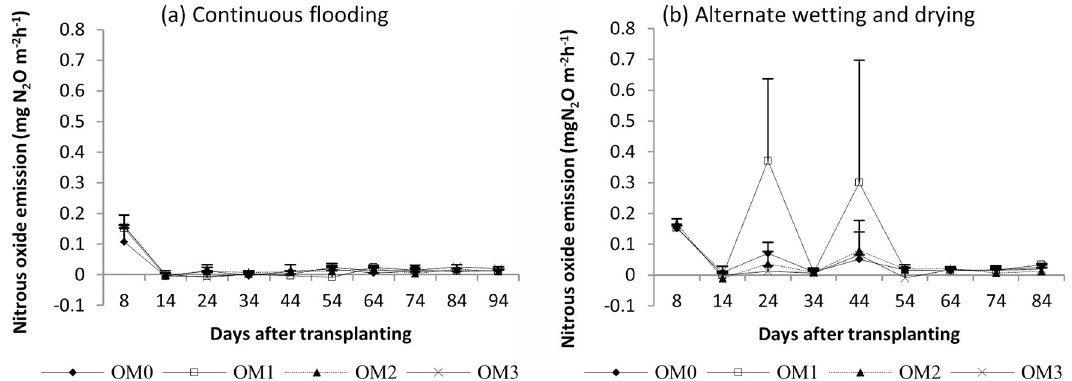
Fig 8. Nitrous oxide emission from rice under (a) continuous flooding and (b) alternate wetting and drying during the dry season, 2017. Mean value ± standard deviation (n = 3).